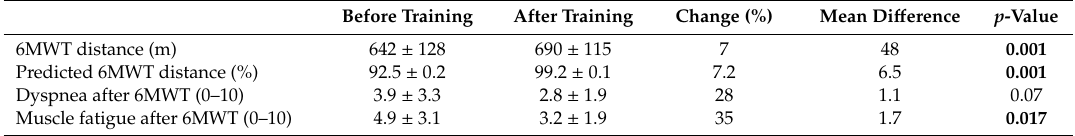
Table 5. Comparison of 6MWT distance, dyspnea score, and muscle fatigue score, before and after the program ( n = 15). Expressed as absolute and relative (percentage of predicted values) values. Before Training After Training Change (%) Mean Di ff erence p -Value 6MWT distance (m) 642 ± 128 690 ± 115